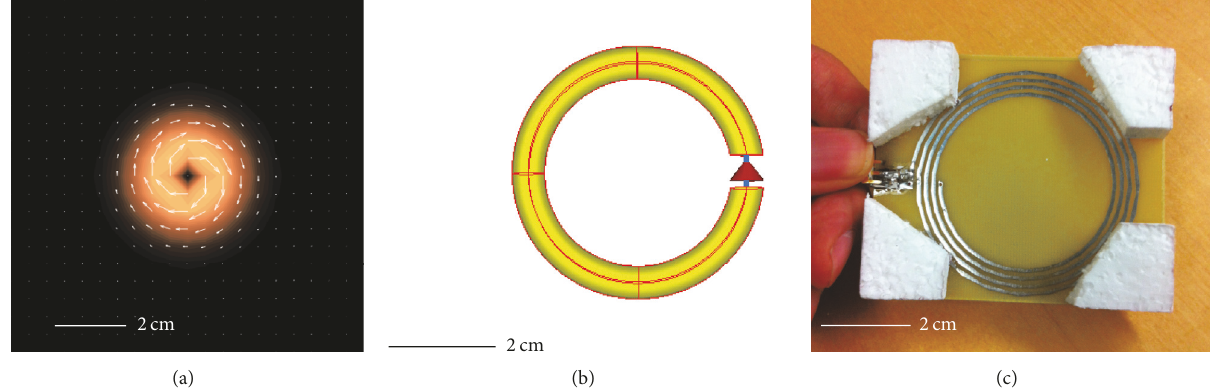
Figure 4: (a) The optimal current distribution for the frequency range of interest. (b) Simulated loop structure resembling the optimal source. (c) Fabricated loop structure with a matching network for the measurement.